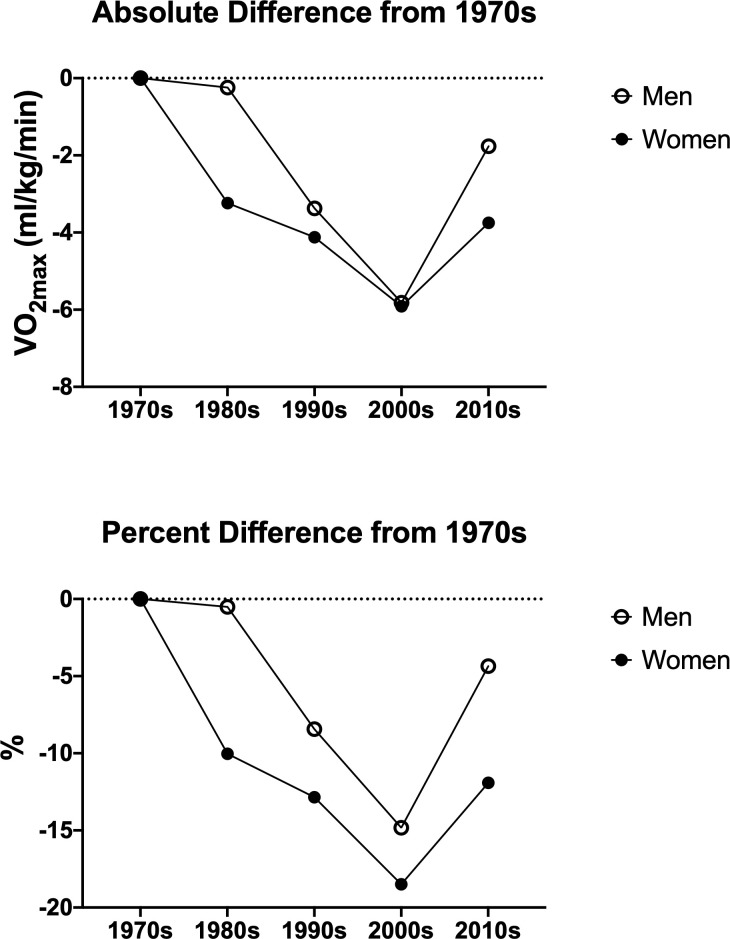
Differences in CRF (i.e., relative VO2max) by decade in comparison to 1970s expressed as absolute difference (top) and percent difference (bottom) for women and men. Values were determined from the means for each decade as presented in Table 3.